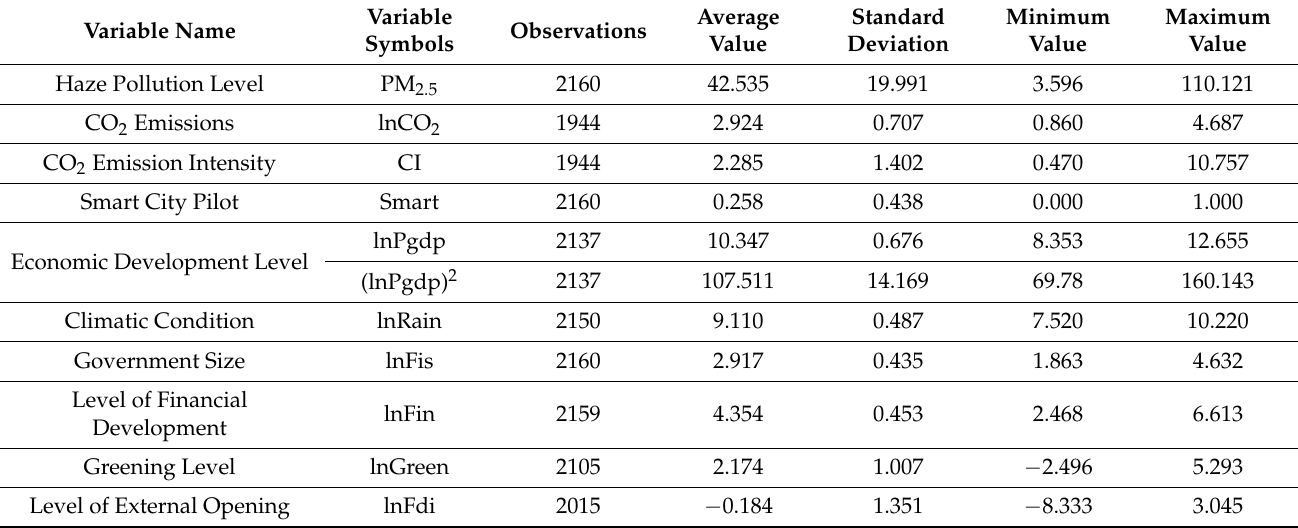
Table 1. Descriptive statistics of